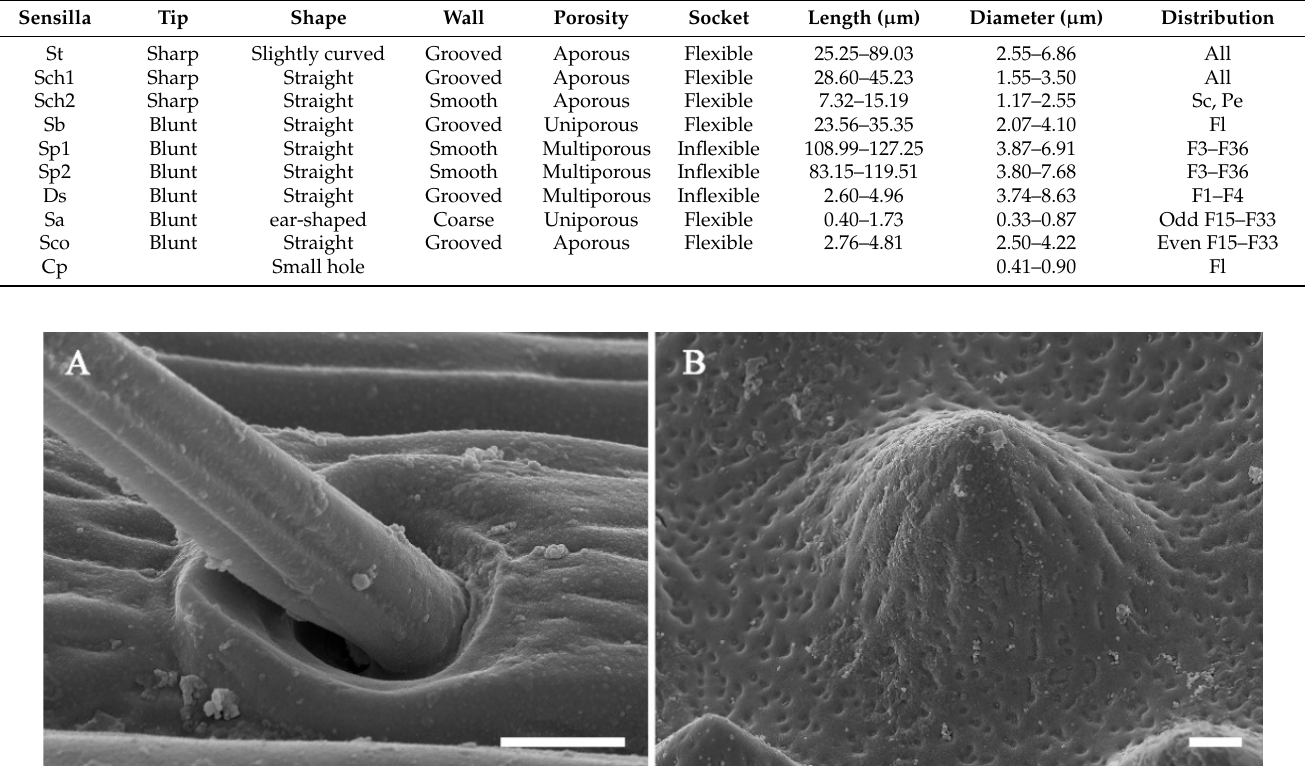
Figure 4. Type of sockets of the antennae of Coeloides qinlingensis . ( A ) Flexible socket at the base of sensilla trichodea. ( B ) Inflexible socket of dome-shaped sensilla. Scale bar: A and B = 1 μ m. Table 2. Morphological characteristics and distribution of the antennal sensilla of female and male Coeloides qinlingensis .